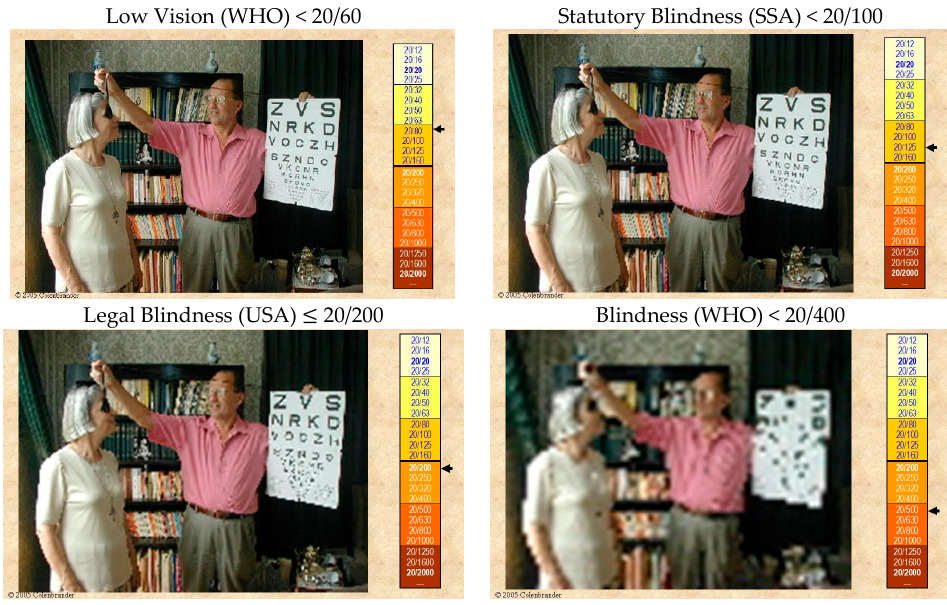
Figure 6. Confusing terminology.